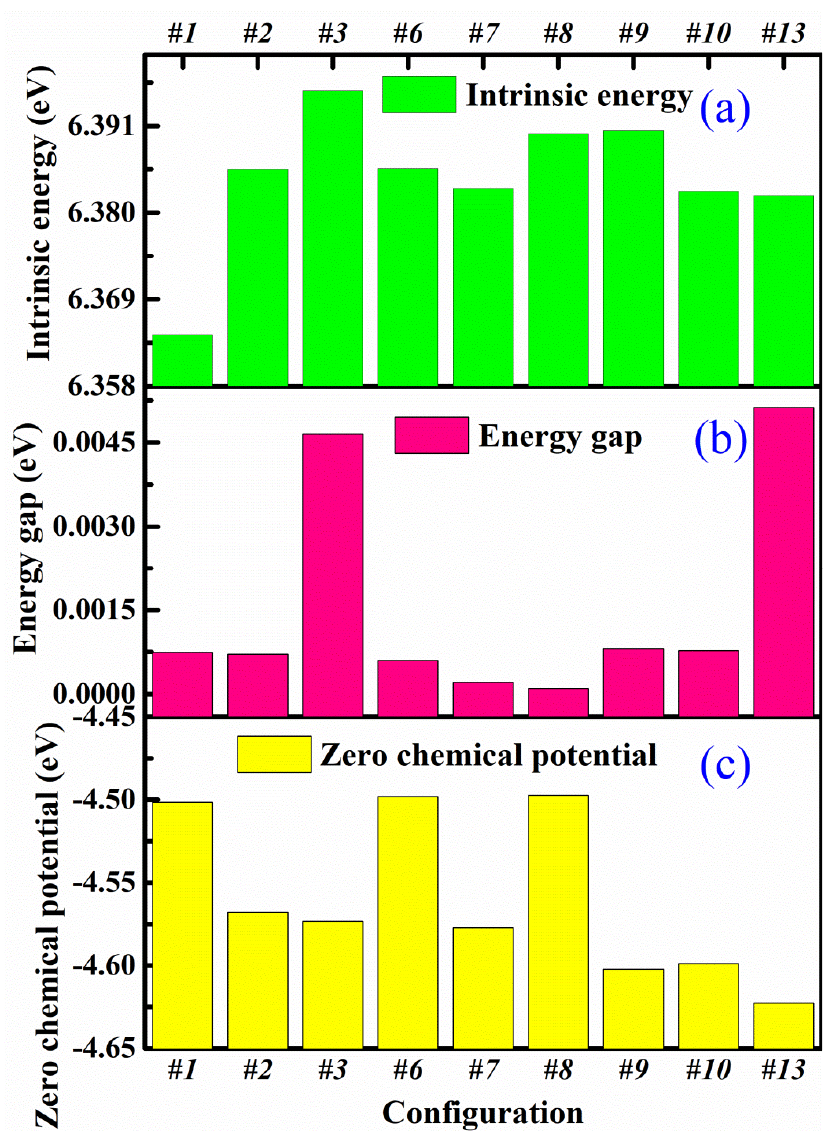
Figure 6. ( a ) Intrinsic energy. ( b ) Energy gap. ( c ) Chemical potential of (8,0)CNT-graphene. Nanomaterials 2022 , 12 , x FOR PEER REVIEW